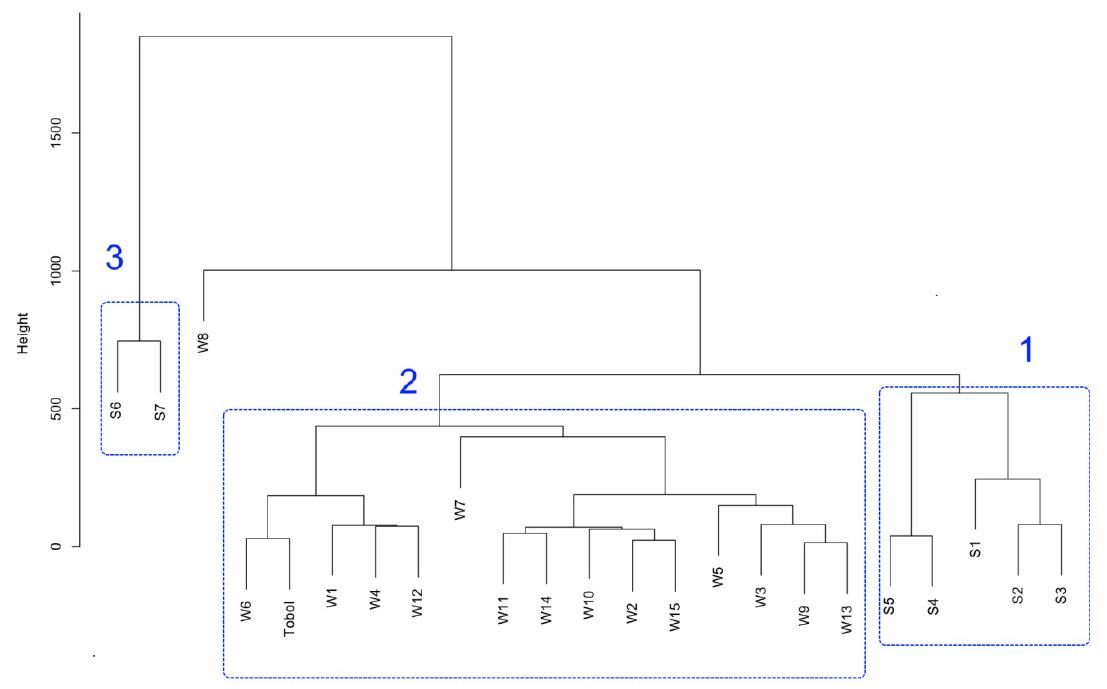
Figure 7. Clustering of sampling points by physico-chemical composition.